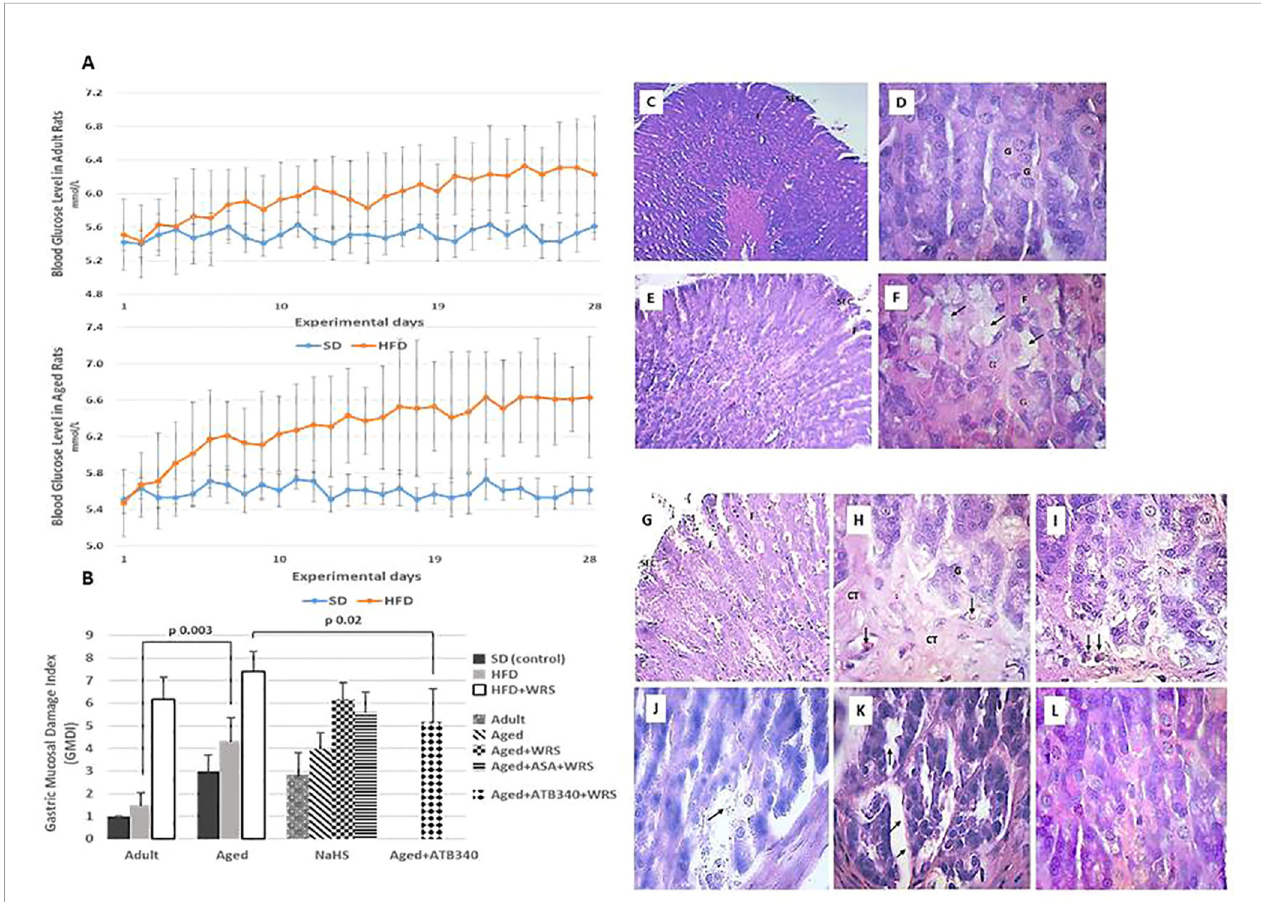
FIGURE 3 | Blood glucose levels in adult ( A , left graph) and aged ( A , right graph) rats fed a standard diet (SD) or high fructose diet (HFD) during 28 days. Results are given as mean ± standard deviation (SD) (statistical analysis: one way-ANOVA, n = 5 – 6/group). Histological characteristic of study groups according to the changes in gastric mucosal damage index (B) and representative photomicrographs to illustrate the changes in the gastric mucosa in adult (C, D) and aged (E – L ) rats fed by 28 days of high fructose diet, visualizing surface epithelial cells (SEC), foveoli (F) , and glandular cells (G) . Hematoxylin and eosin staining at low (C – x 150; E and G – x 200) and higher magni fi cation ( D , F , and H – L – x 600). Gastric mucosa of adult and aged rats shows glandular cells ( D , F , respectively), and hypertrophy of mucous neck cells (arrows) (F) . In the gastric mucosa of vehicle-treated aged rats exposed to acute stress (G, H) and aspirin pretreatment (I), there is observed connective tissue (arrows) in basal third of the gastric mucosa, hyperemia in lamina propria (arrows). The gastric mucosa of aged rats exposed to acute stress and pretreated by NaHS (J) , a combination of NaHS and aspirin (K) shows uneven swelling of the submucosal base in gastric mucosa (arrows) while pretreatment of ATB-340 (L) shows diffuse swelling of the submucosal basis of gastric